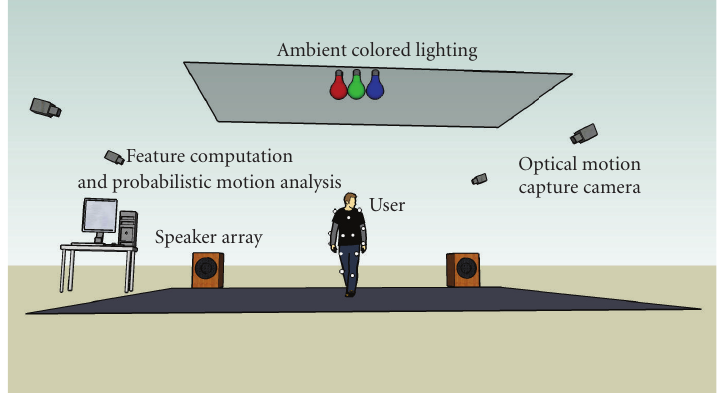
Figure 3: System overview schematic diagram.